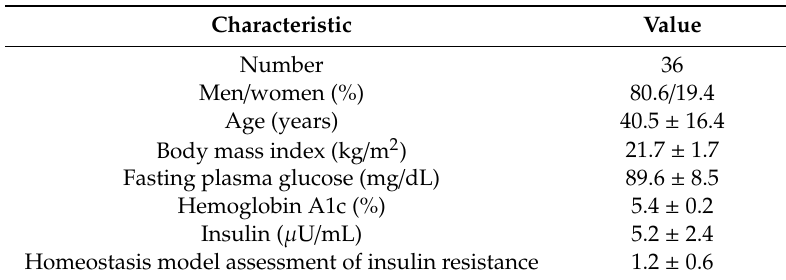
Table 2. Baseline